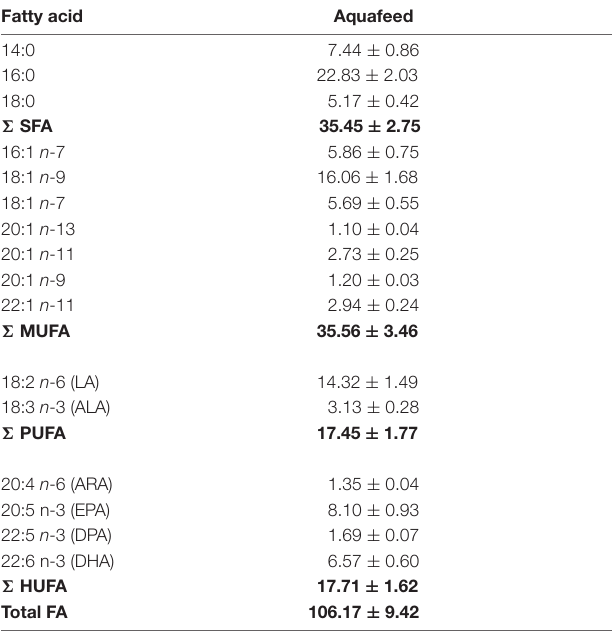
TABLE 2 | Fatty acid (FA) profile ( µ g mg − 1 DW) of the commercial aquafeed (WIN flat –SPAROS) supplied to Hediste